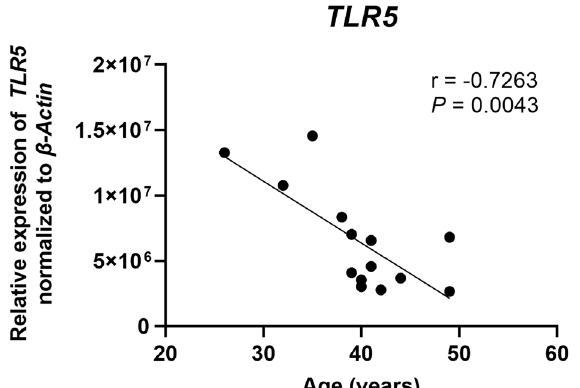
Figure 2. TLR5 expression decreases with increasing age in premenopausal women. TLR5 mRNA expression was determined by real-time RT-PCR for endometrial epithelial cells grown in vitro from premenopausal women ( n = 14), isolated from either the proliferative or secretory phase, between the ages of 26–49 years. Expression is normalized to the expression of the housekeeping gene β-Actin . Each symbol represents an individual patient. Non-parametric Spearman correlation analysis